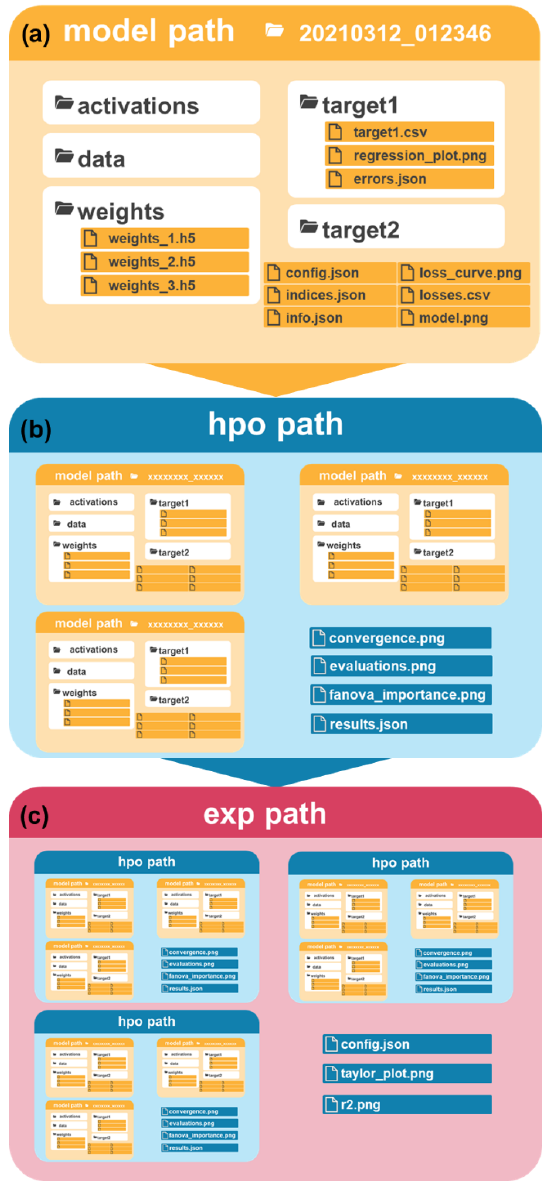
Figure 2. Output directory structure of AI4Water. A “model path” (a) is created upon creation of a new model. An “hpo path” (b) is created during hyperparameter optimization. An “exp path” (c) is created when several models are compared during an experiment. The “hpo path” consists of several “model paths”, and an “exp path” consists of several “hpo paths”.